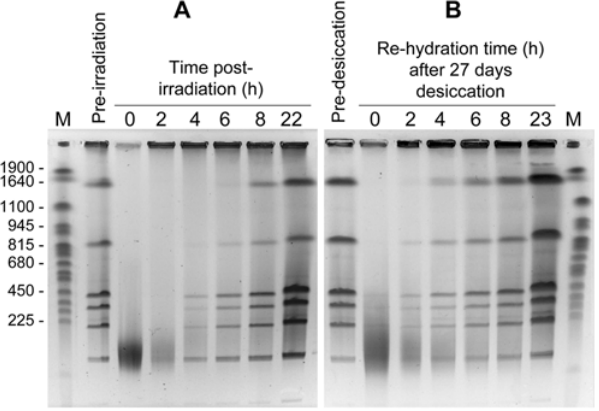
Figure 1. Kinetics of genome reconstitution in D.deserti after gamma radiation and after desiccation. D. deserti cells were subjected to 6.8 kGy gamma rays (Panel A) or 27 days of dessication (Panel B). Genomic DNA, purified from cells before irradiation or desiccation and at different times after irradiation or rehydration, was digested with PmeI and SwaI, resulting in 8 DNA fragments for an intact genome, and separated by pulsed-field gel electrophoresis (PFGE). Lanes M, Yeast Chromosome PFG Marker (New England Biolabs). Lengths (in kb) of several marker fragments are indicated on the left.